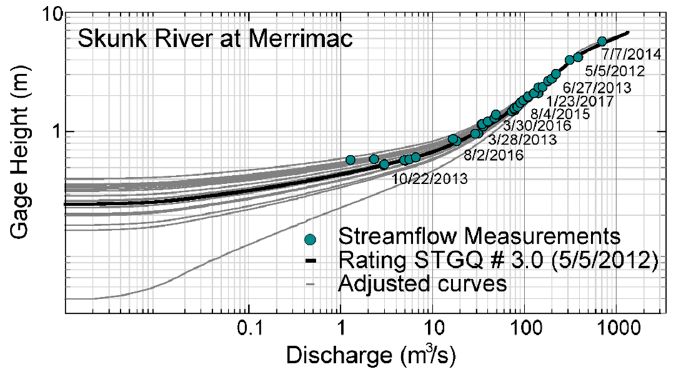
Figure 3. Adjusted rating curves in Skunk River at Merrimac. Cyan dots represent streamflow measurements, the black line represents the base rating curve and the gray lines represent the adjusted curves used at various times during the study.